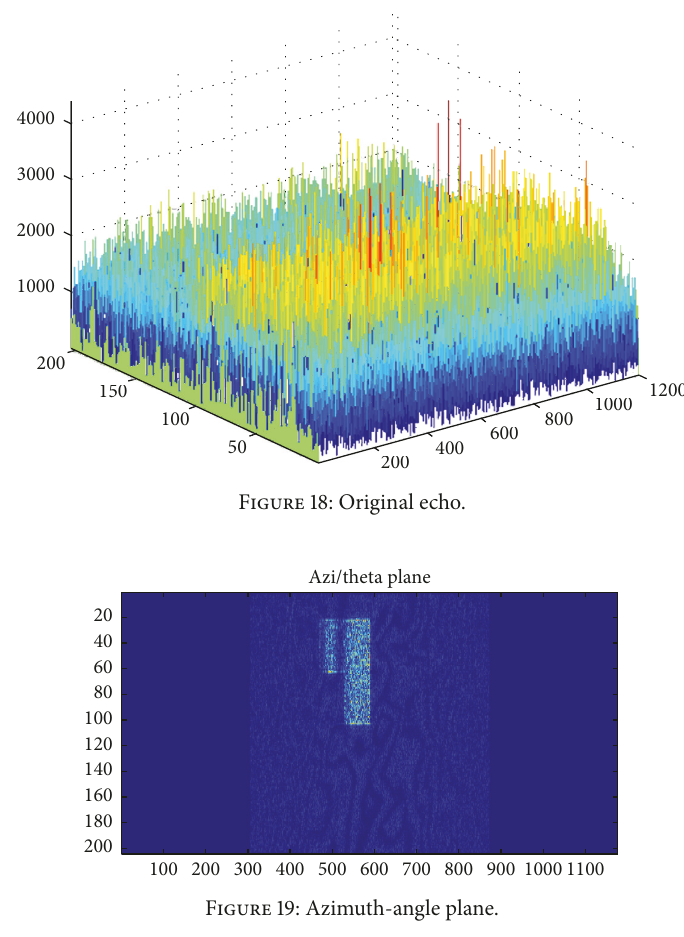
Figure 19: Azimuth-angle plane.